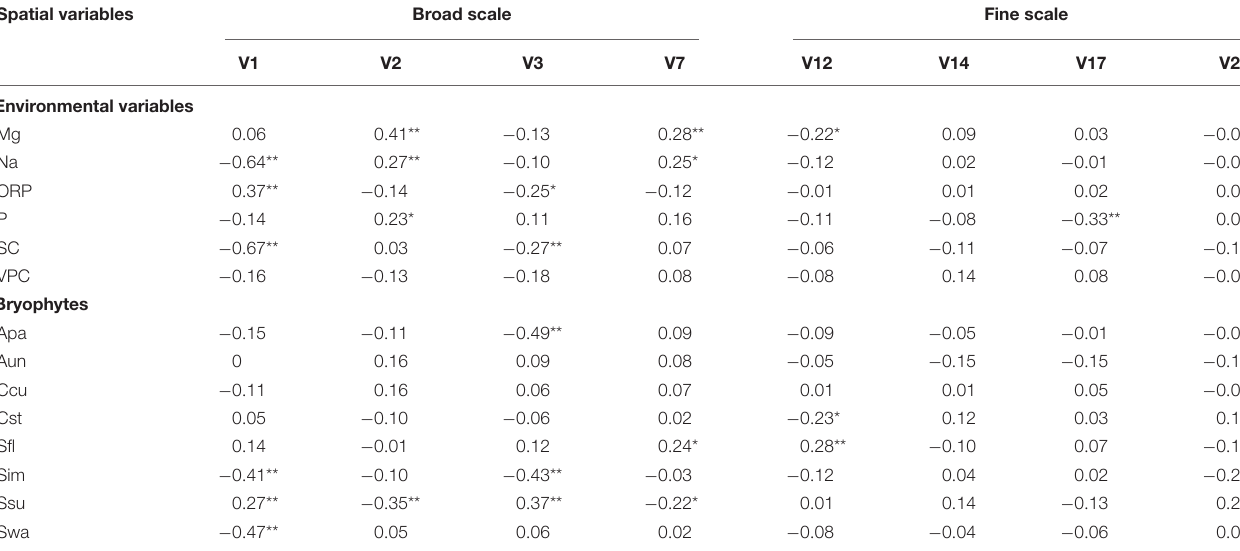
TABLE 2 | The Pearson correlation between the spatial variables and environmental variables and between spatial variables and bryophyte covers. Spatial variables Broad